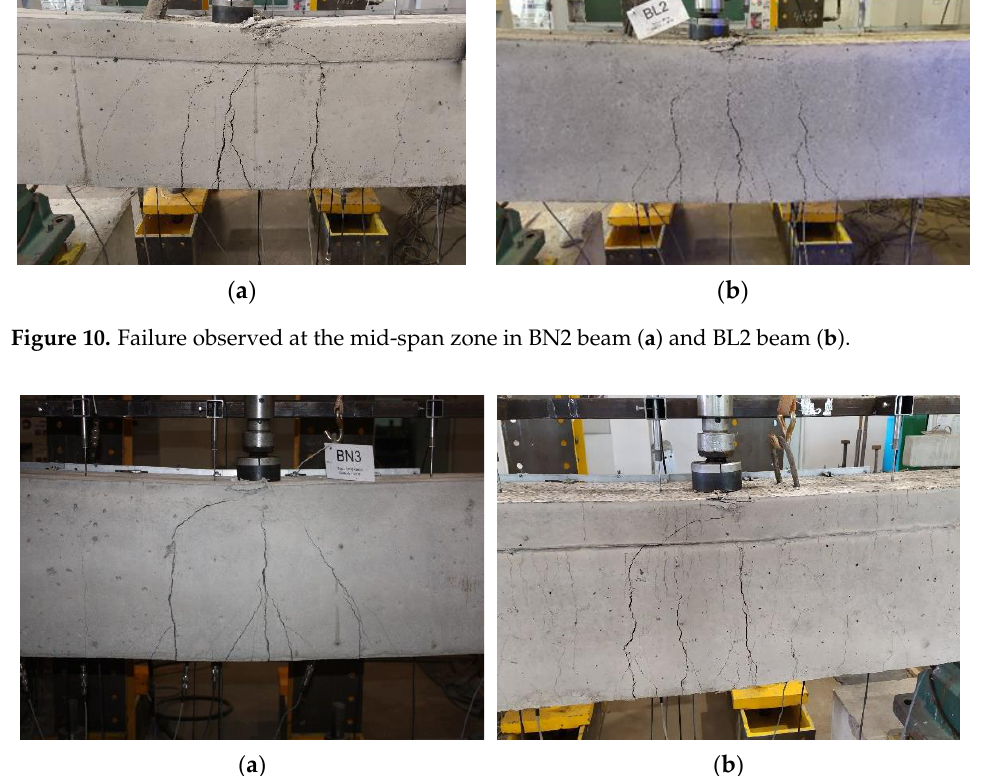
Figure 11. Failure observed at the mid-span zone in BN3 beam ( a ) and BL3 beam ( b ).